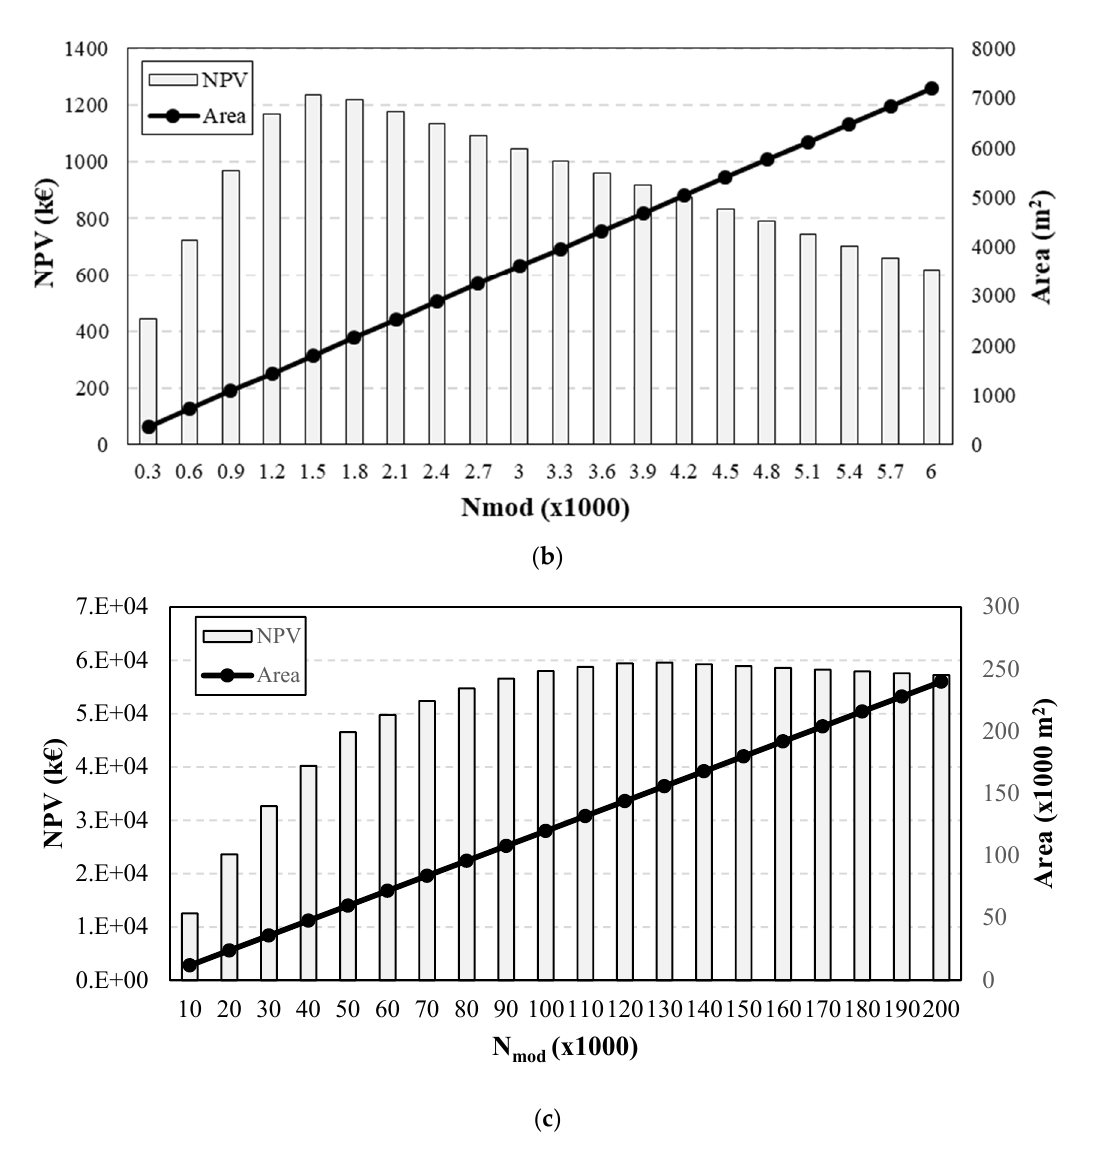
Figure 7. Net present values (NPVs) at the 20th year by varying number of modules for the three users defined: ( a ) house; ( b ) hotel; and( c ) industry.